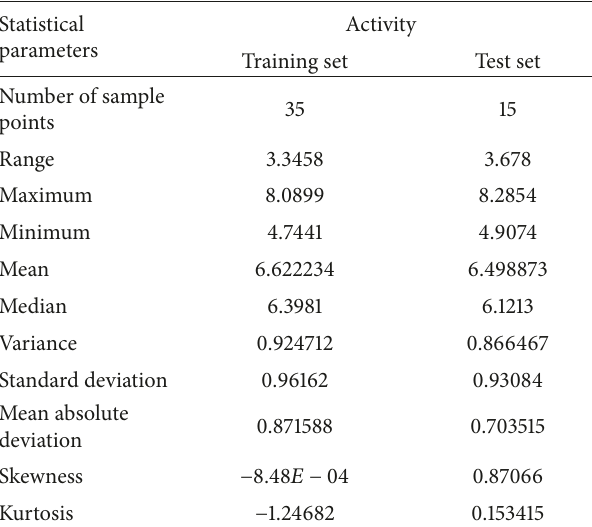
Table 5: Descriptive statistics of the inhibition